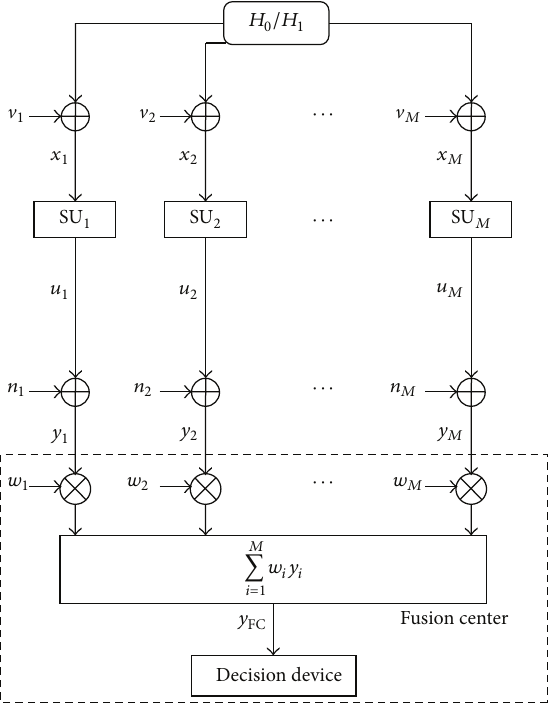
Figure 2: System model for weighted cooperative spectrum